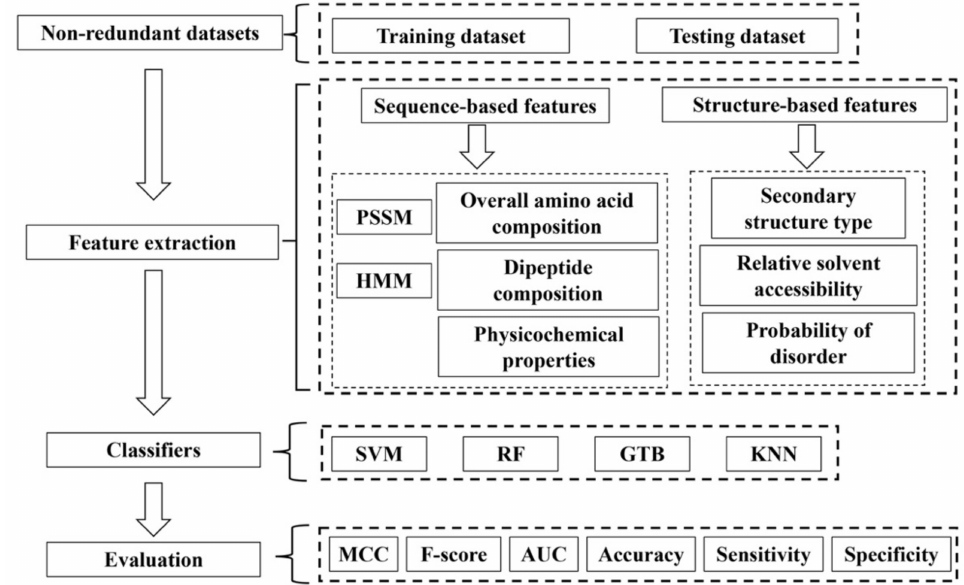
Figure 3. The flowchart for machine learning-based prediction of